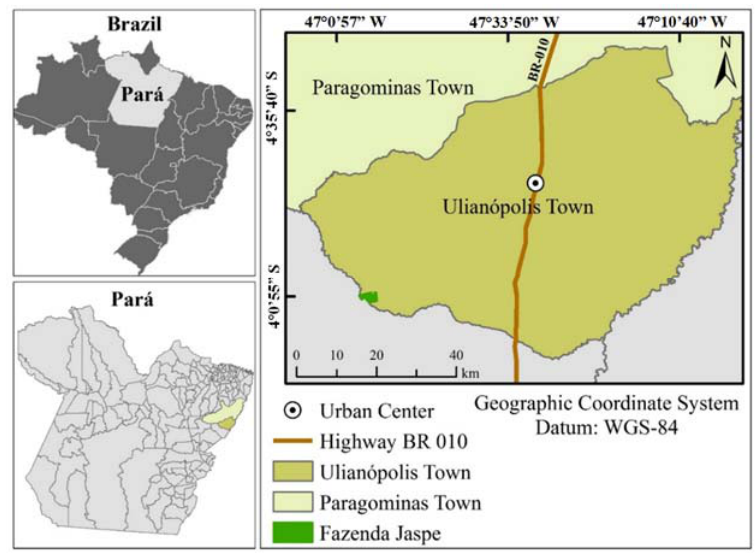
Figure 1. Location of the study area, Fazenda Jaspe, town of Ulianópolis, Pará, Brazil. The original vegetation of the area is classified as dense tropical submontane forest.